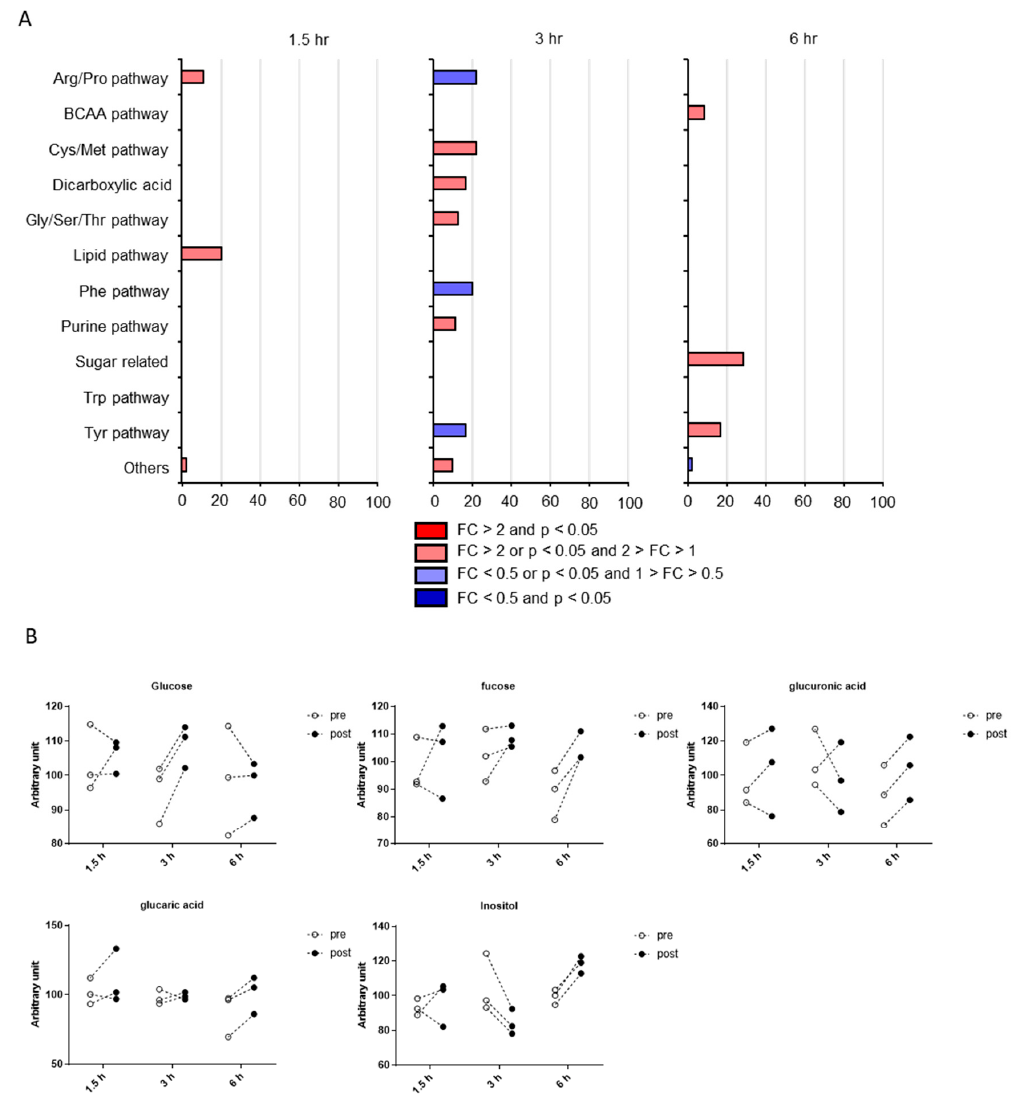
Figure 5. Pathway occupancy rates of putative hydrophilic metabolites altered by postprandial effects. ( A ) Pathway occupancy rates are listed as percentages. Statistical significance using hypergeometric tests is indicated as follows: * p < 0.05, ** p < 0.01. ( B ) Levels of hydrophilic metabolites in the sugar-related pathway and their precursor, glucose.